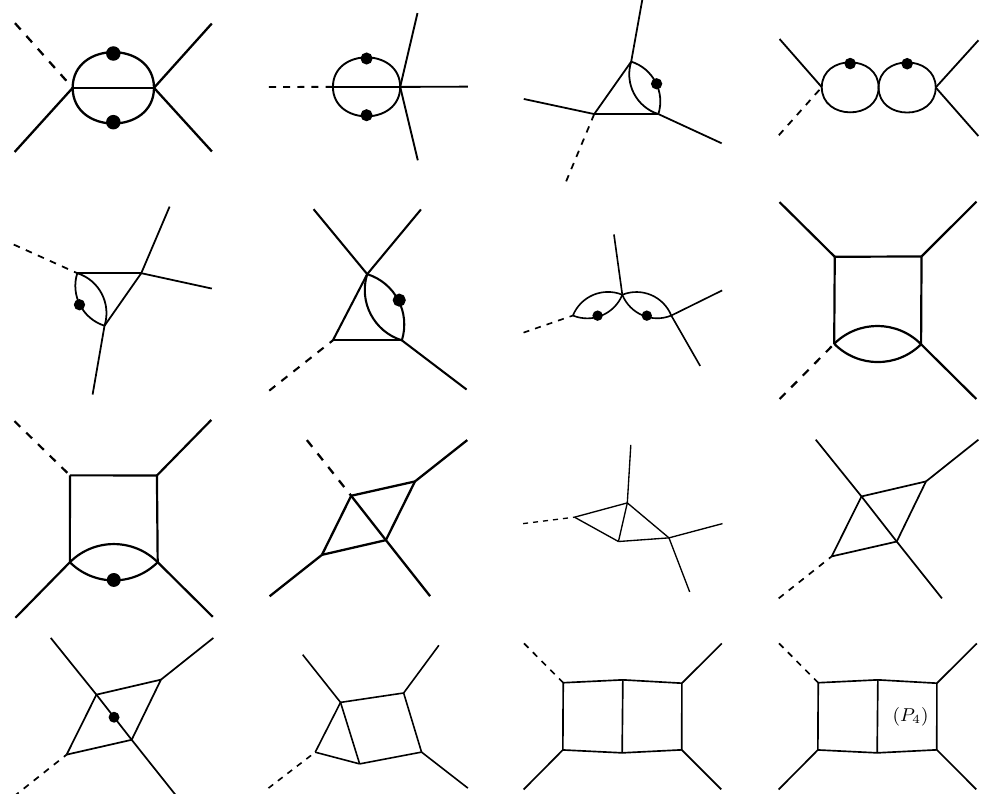
Figure 2. Planar topologies which appear in the canonical basis. The dashed line is the massive leg, dots represent squared propagators. A propagator in brackets denotes an integral with this propagator in the